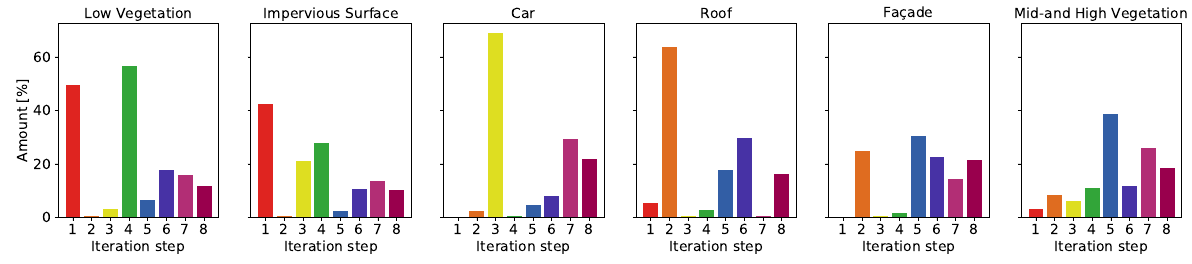
Figure 5. Relative amount of selected points per class and iteration step queried within the AL pipeline.